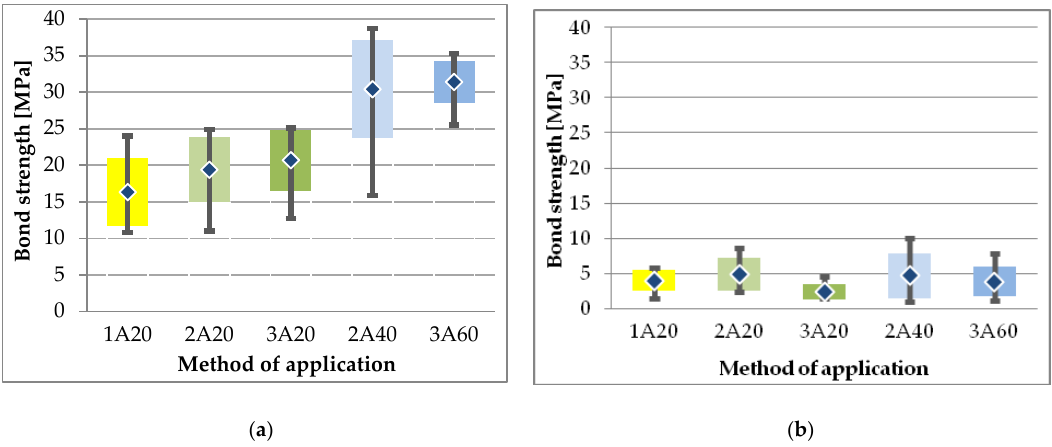
Figure 9. SBS results for multi-mode adhesives: ( a ) Single Bond Universal; ( b ) Prime & Bond One Select.